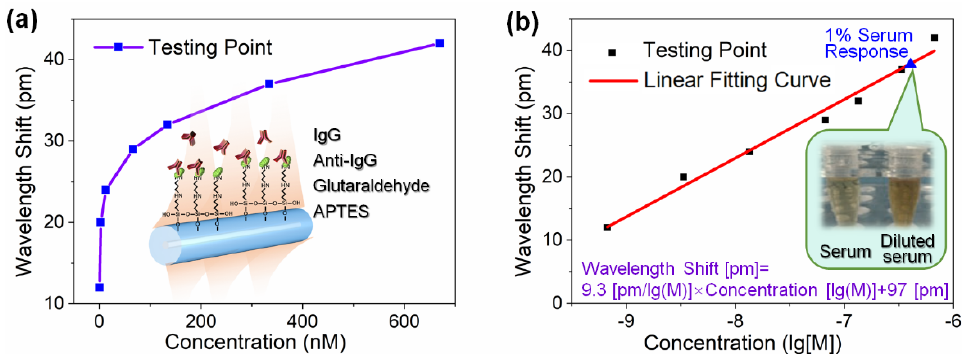
Figure 5. ( a ) The wavelength response of the cladding mode resonance increases with IgG concen- tration. Inset: schematic illustration for the functionalization of the FBG sensor with an anti-IgG aptamer and an IgG detection kit. ( b ) Wavelength response as a function of the IgG concentration on a logarithmic scale.